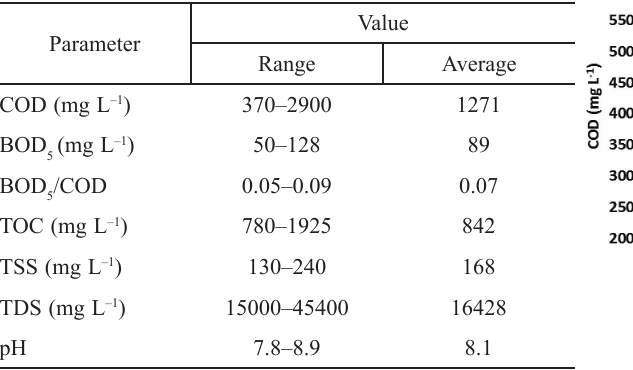
Table 1 – Characteristics of high saline petrochemical wastewater Parameter